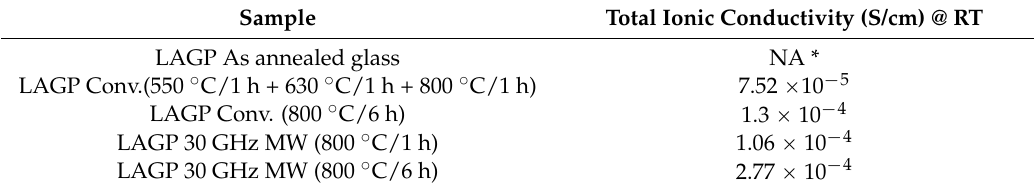
Table 3. Ionic conductivities of some conventionally and MW heat-treated LAGP samples at different temperatures and holding